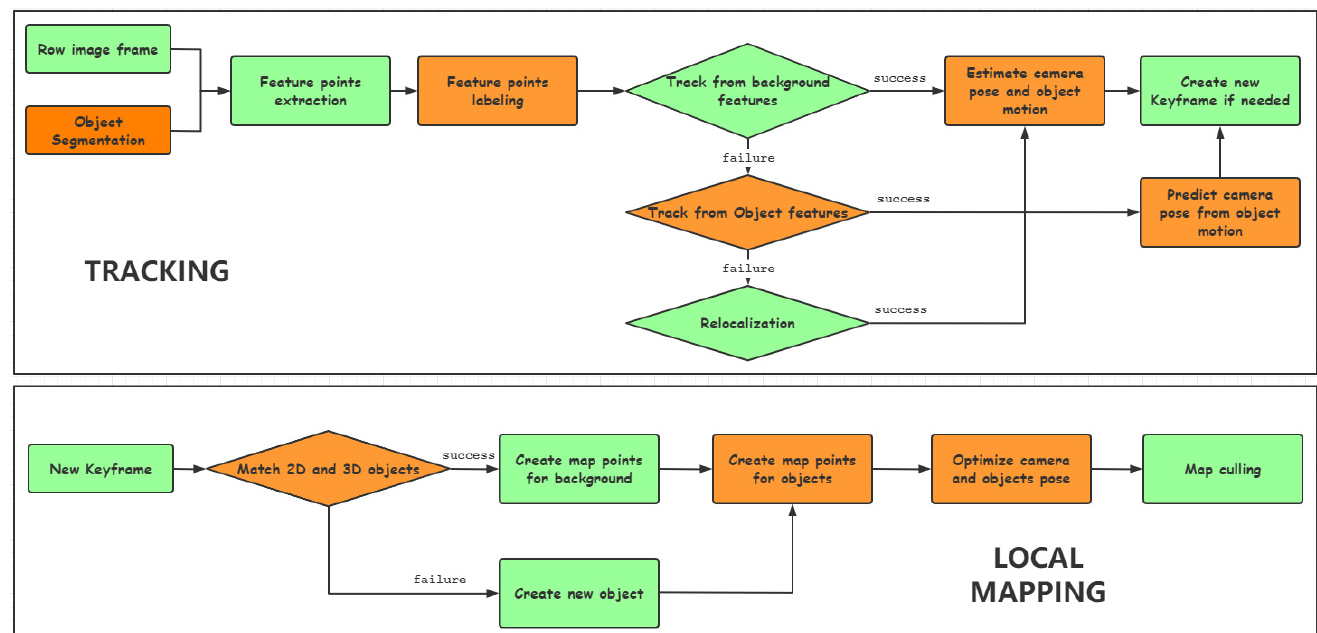
Figure 1. Tracking ( top ) and local mapping ( bottom ) of DOE-SLAM. The changes compared with ORB-SLAM2 are shown in orange boxes.